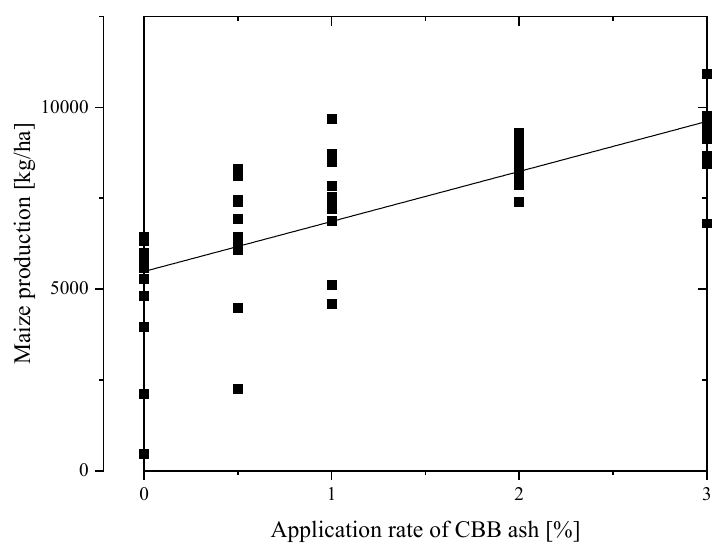
Figure 1. Change of maize production with CBB ash application rates.